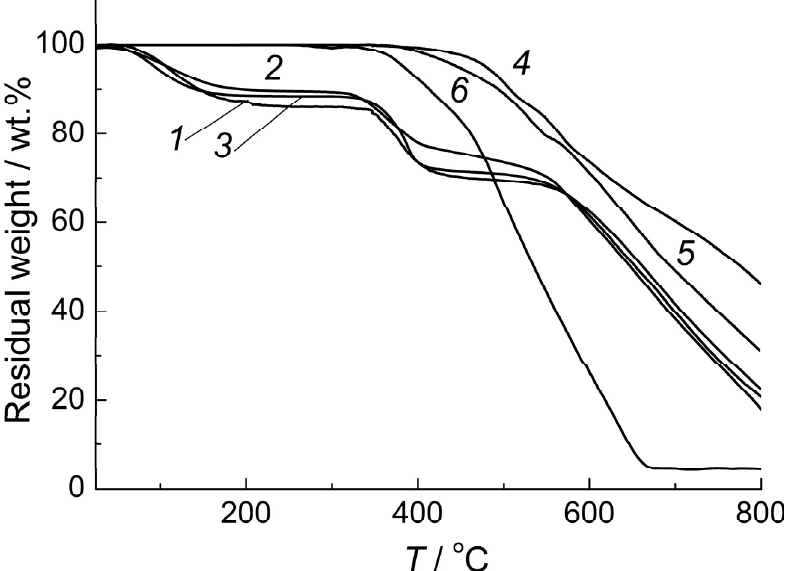
Figure 3. TGA curves for SPNBI-I,III (1), SPNBI-II,III (2), and SPNBI-II,IV (3) and K (4), Ca (5),